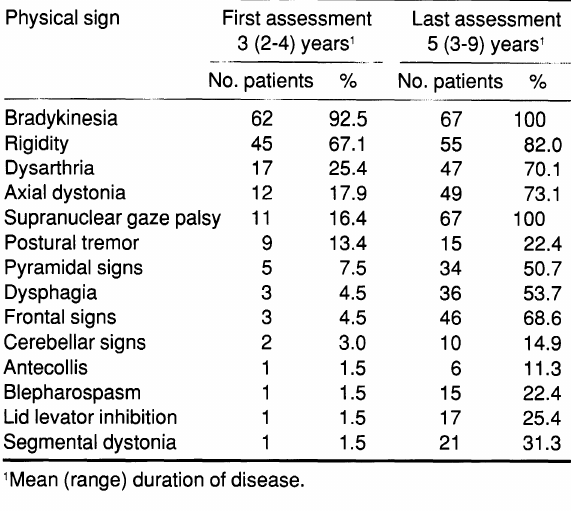
TABLE II. Frequency of physical signs at initial and at final assess ment in 67 patients with SROS Physical sign